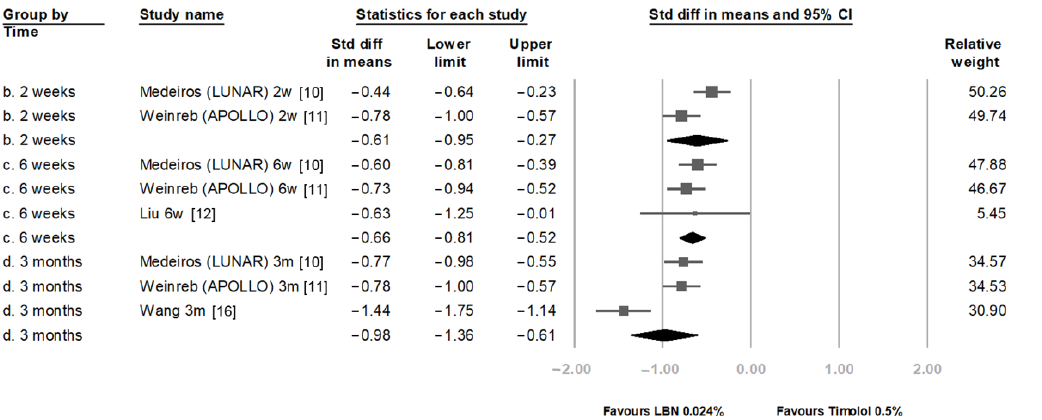
Figure 3. Comparison of IOP-lowering effect between latanoprostene bunod 0.024% and timolol maleate 0.5%.